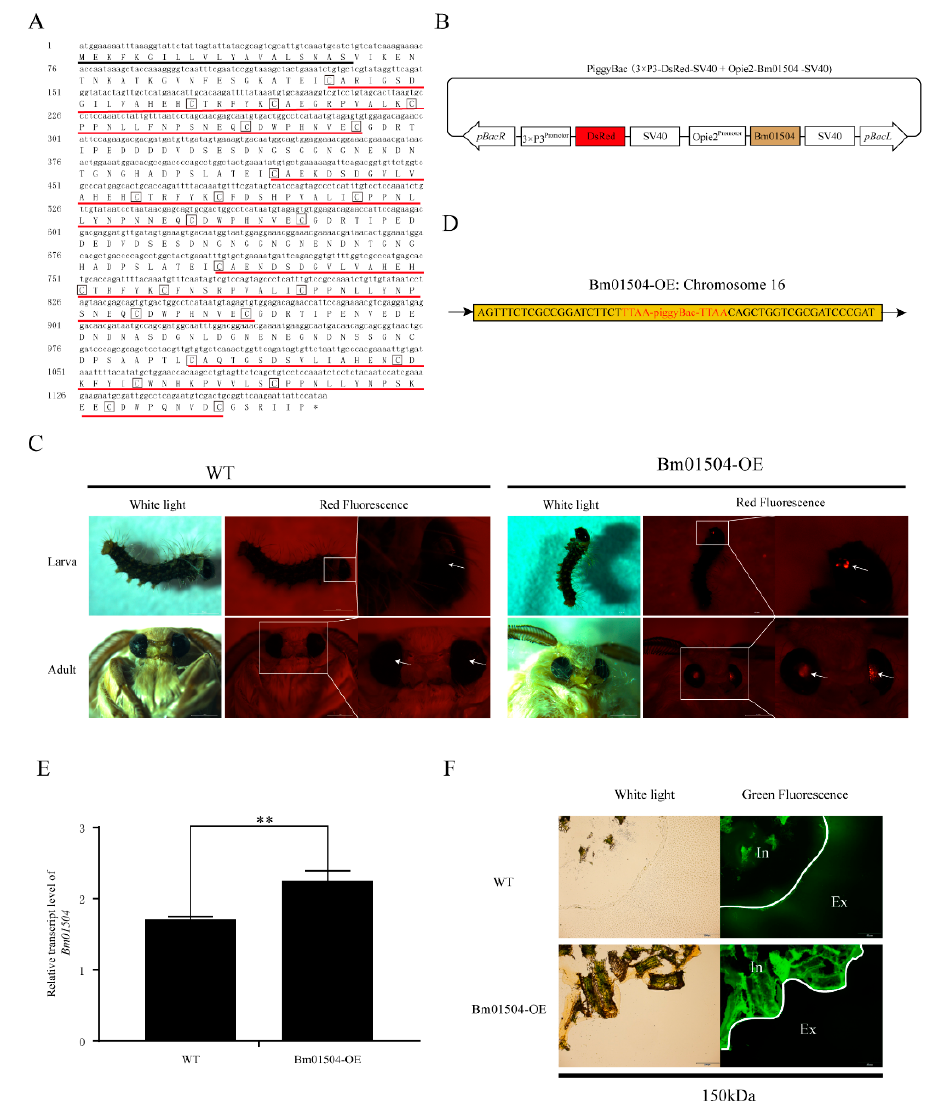
Figure4. GenerationofBm01504overexpression(Bm01504-OE)transgenicsilkworms.( A )Thenucleotide sequence of cDNA for Bm01504 and its deduced amino acid sequence. The black line indicates the signal peptide sequence, the red line indicates the four CBDs, and conserved cysteine residues are boxed; ( B ) Schematic diagram of the piggyBac (3 × P3-Discosoma sp. red fluorescent protein (DsRed)-SV40 + Opie2-Bm01504-SV40) transgenic vector. Bm01504 was driven by Opie2 promoter, DsRed was driven by the 3 × P3 promoter and SV40 was used for transcription termination signals. Hyperactive promoter containing three binding sites for Pax-6 homodimers in front of TATA box are indicated by 3 × P3 promoter. DsRed, Discosoma sp. Red Fluorescent Protein. Opie2 promoter, Orgyia pseudotsugata multicapsid nucleopolyhedrovirus (OpMNPV) immediate-early 2 (ie2) promoter. SV40, terminator of Simian virus 40 . pBacL and pBacR indicate the left and right terminal inverted repeats, respectively; ( C ) Images of larvae and adults of transgenic silkworm with white light and red fluorescence. WT, Wildtype. Whitearrowsindicatepositionsofeyesinlarvaeandadults;( D )InsertionsitesinBm01504-OE transgenic silkworms analyzed using inverse PCR; ( E ) The messenger RNA (mRNA) level of Bm01504 in Bm01504-OE transgenic silkworms was determined by qRT-PCR. Values with p < 0.05 were considered statistically significant (** p < 0.01); ( F ) The anterior peritrophic membrane (PM) permeability of Bm01504-OE transgenic silkworms was evaluated using Fluoresceine isothiocyanate (FITC)-dextran (150 kDa) using fluorescence microscopy (100 × ). In, Internal. Ex, External. White lines show the localization of the